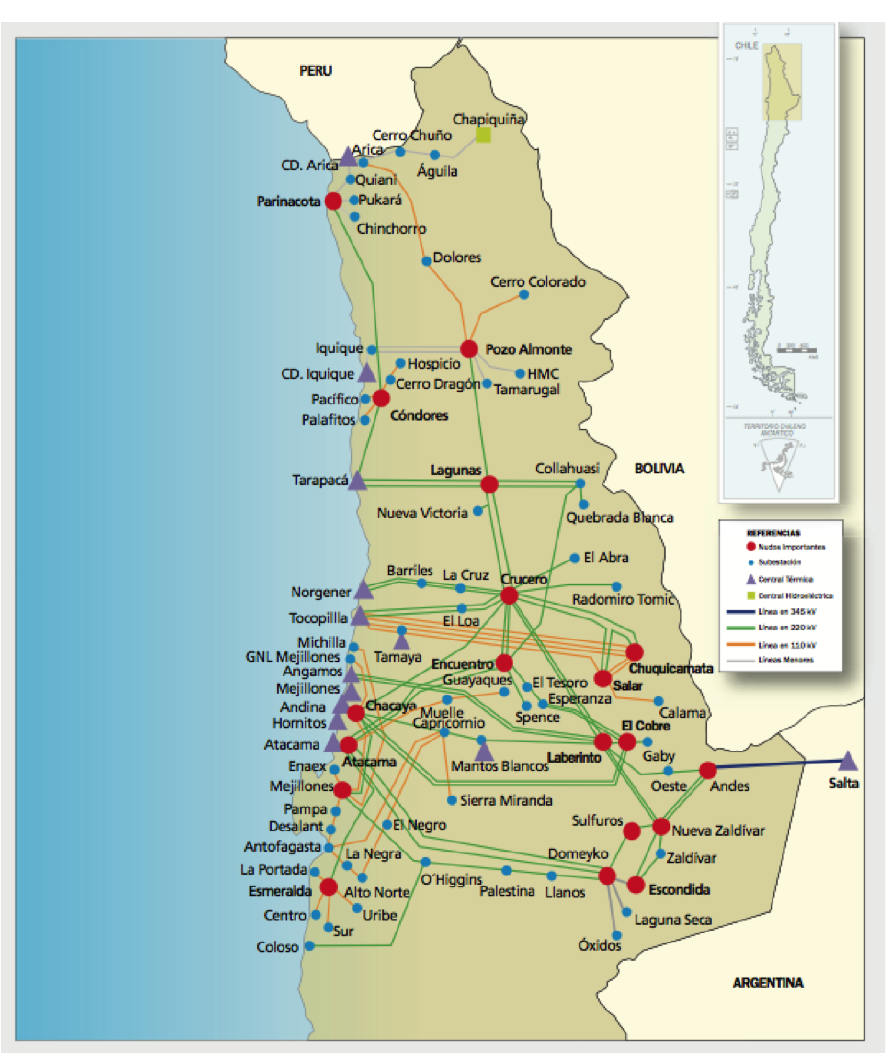
Figure 10. Equivalent diagram of the Chilean Northern Interconnected Power